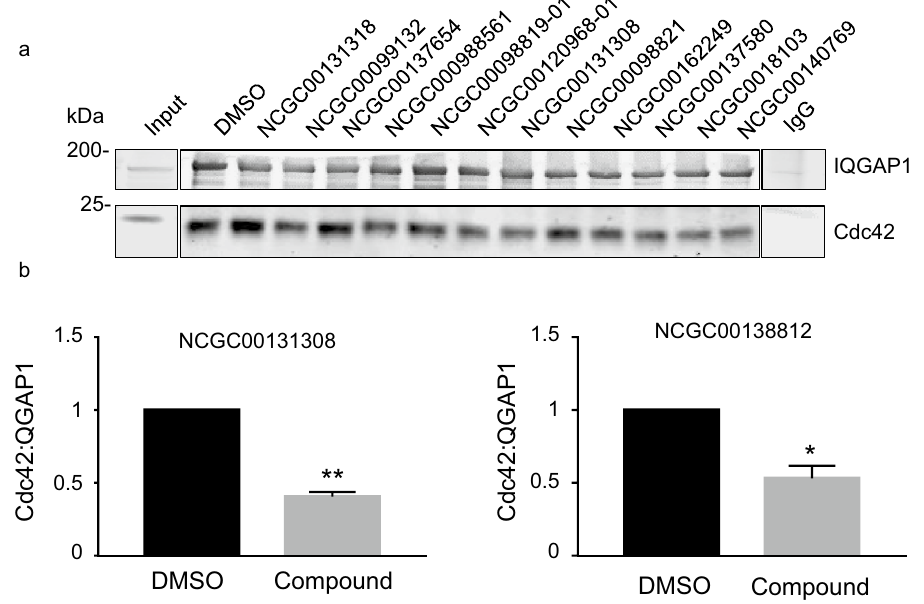
Figure 3. Compounds that impair the IQGAP1/Cdc42 interaction in cell lysates. ( a ) HEK293 cell lysates were prepared as described in the Methods section. The selected compounds (50uM) or DMSO (vehicle) were added to equal aliquots of protein lysates and endogenous IQGAP1 was immunoprecipitated with polyclonal anti-IQGAP1 antibodies. Anti-rabbit IgG was used as the negative control (last lane). Immune complexes were analyzed by SDS-PAGE and transferred to PVDF membrane. Western blots were probed with anti-IQGAP1 and anti-Cdc42 antibodies. 1% of the protein lysates was loaded directly onto the gel (Input). The data are representative of at least three independent experiments. Vertical lines indicate where irrelevant lanes were removed from the blots and added sections from a separate blot. Full-length blots are presented in Supplementary Fig. 5. ( b ) The IQGAP1 and Cdc42 bands were quantified with Image Studio 2.0 (LI-COR Biosciences) and the amount of Cdc42 was corrected for IQGAP1 in the same sample. Data from 16 µM NCGC00131308 to 0.2 µM NCGC00138812 are shown. The data are expressed as means ± SEM (error bars) with DMSO set to 1 (n = 3). Statistical analysis was conducted using paired Student’s t-test, * p < 0.05 and ** p < 0.01 compared to